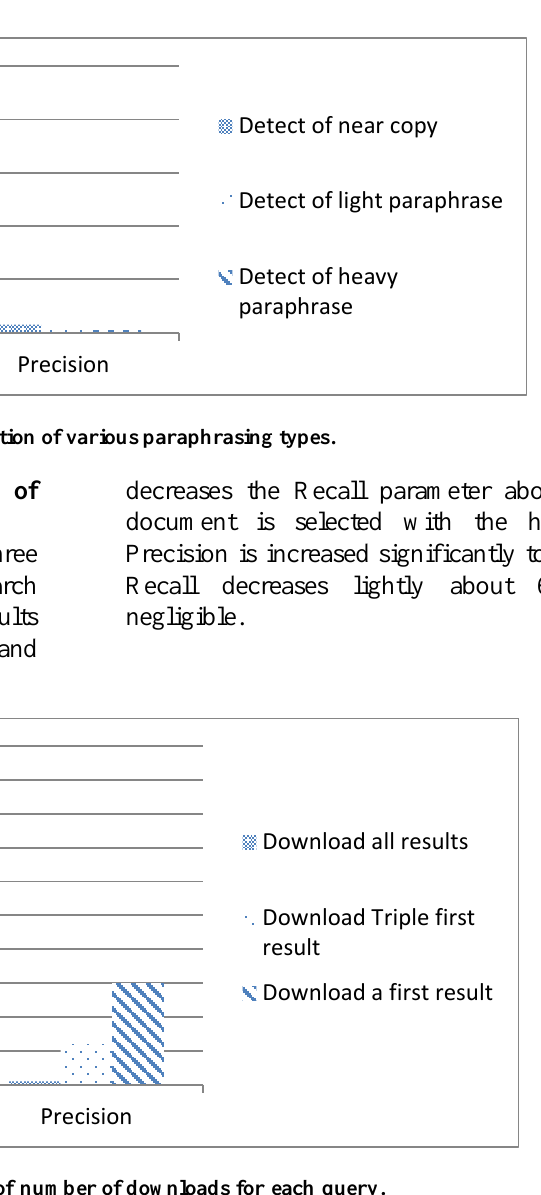
Table 9. Comparison of ParaMaker against PAN2014’s best detectors. Software Team/